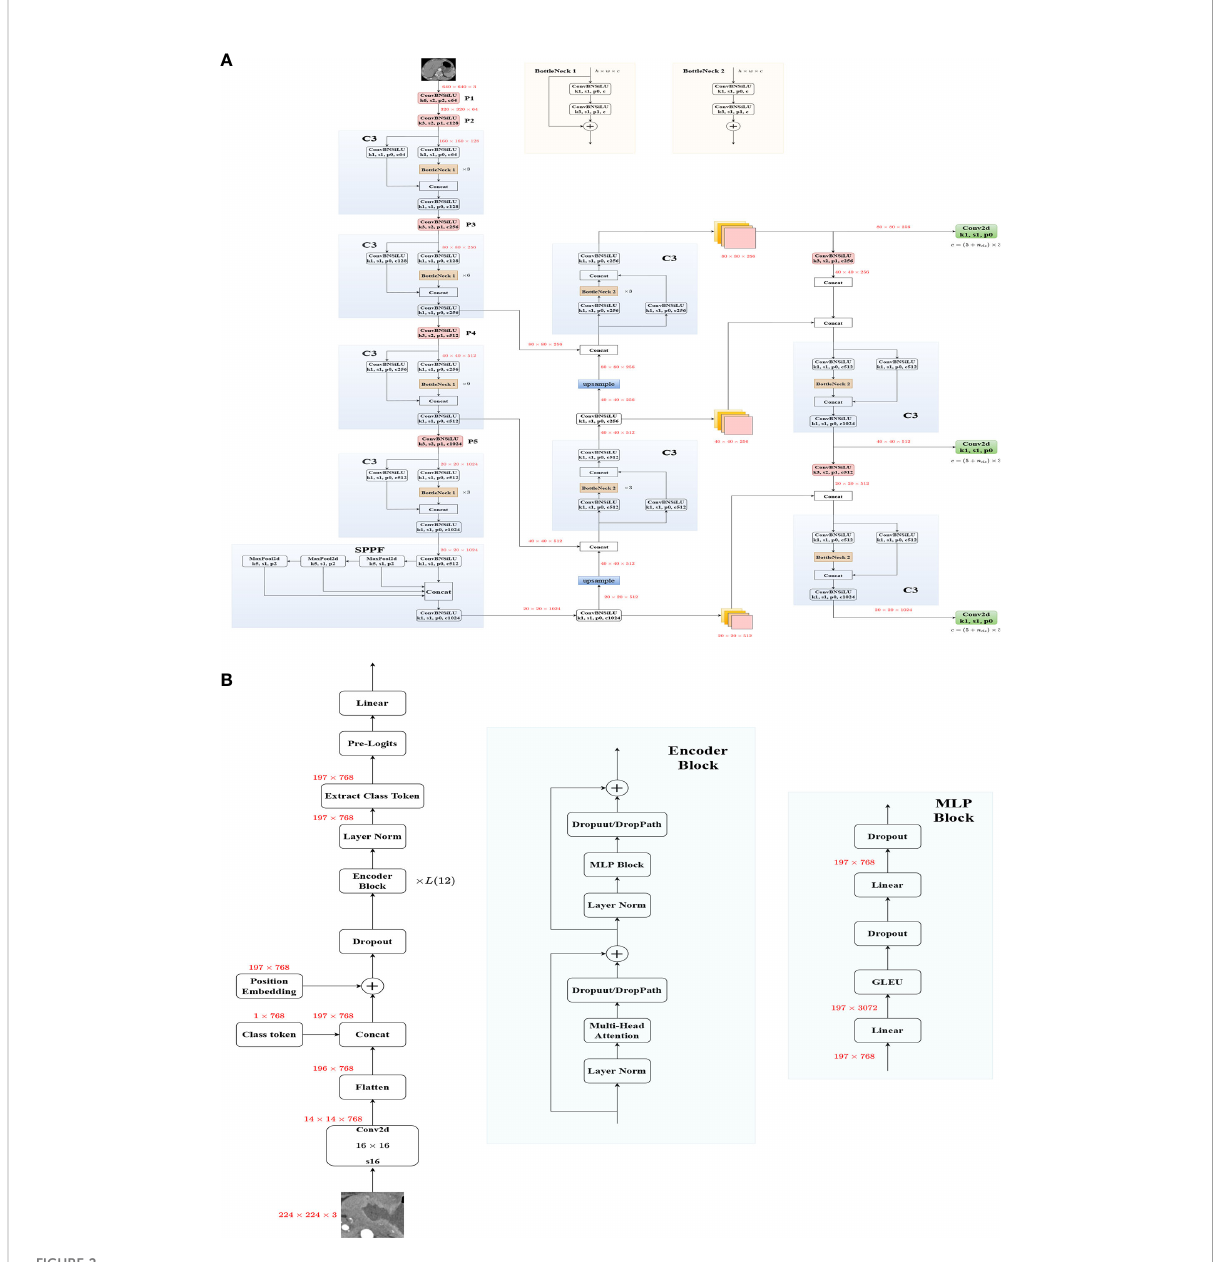
FIGURE 2 The overall network structure of Yolov5 (A) and VIT (B)